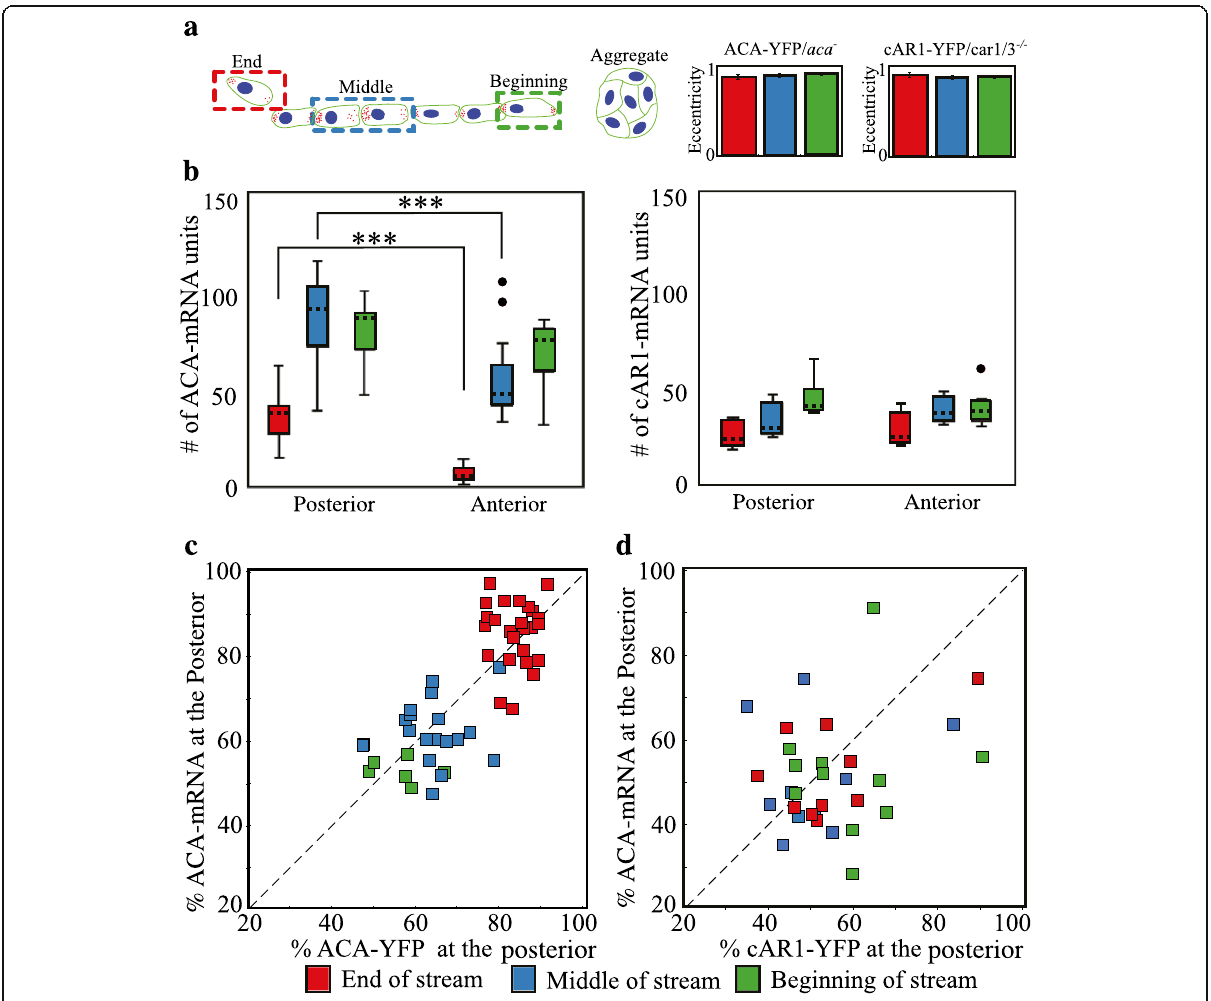
Fig. 2 The ACA mRNA is asymmetrically distributed at the posterior of the streaming cells. a Left : Cartoon depicting the distribution of cells within a stream. Each cell was characterized as either being at the end, in the middle or at the beginning of a stream based on its position relative to the aggregate center. Right : Eccentricity measurement of ACA-YFP/ aca − and cAR1-YFP/ car1/3 − / − cells at the various positions within streams (n ACA = 45, n cAR1 = 24). b The simulated estimate of mRNA units across cells is plotted for ACA-YFP/ aca − and cAR1-YFP/ car1/3 − / − cells, as a function of their position in a stream. Boxes show the 50% confidence region from the median ( dashed black line ). The bars cover a region with 99% confidence level from the median. All data points beyond this confidence level are considered as outliers and shown with black dots . The statistical significance is inferred by the t-test, *** represents p < 0.001 ( n = 15 – 52). c - d The average proportion of mRNA and its corresponding protein at the posterior of cells is presented